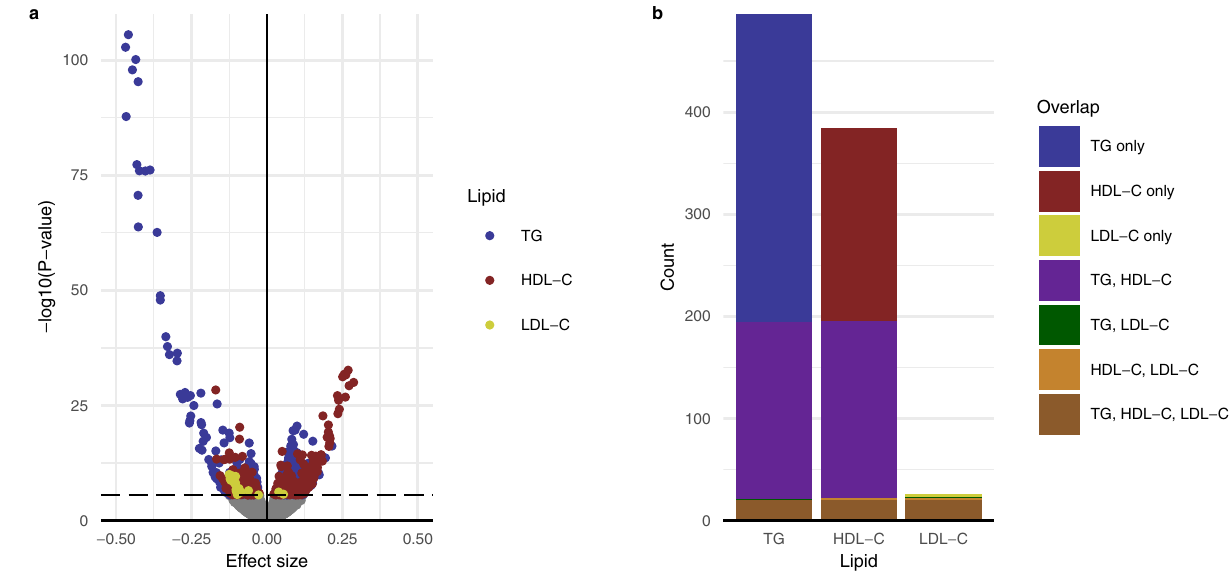
Fig. 1 | A transcriptome-wide analysis reveals genes associated with lipids. a Volcano plot depicting the relationship between linear regression effect size in the standard deviation of lipid levels and − log10( P -value) for the association between lipid levels and transcription for TG, HDL-C, and LDL. Points depicted in